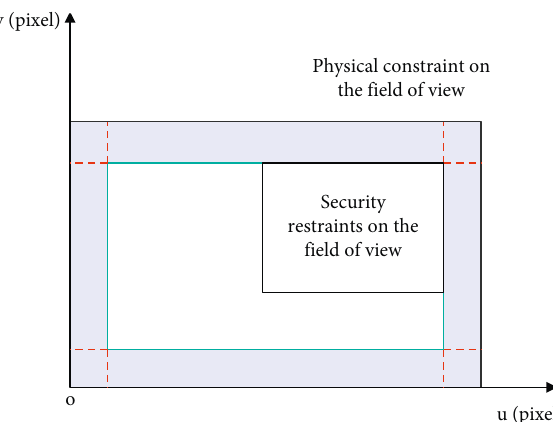
Figure 1: Image field-of-view constraint range